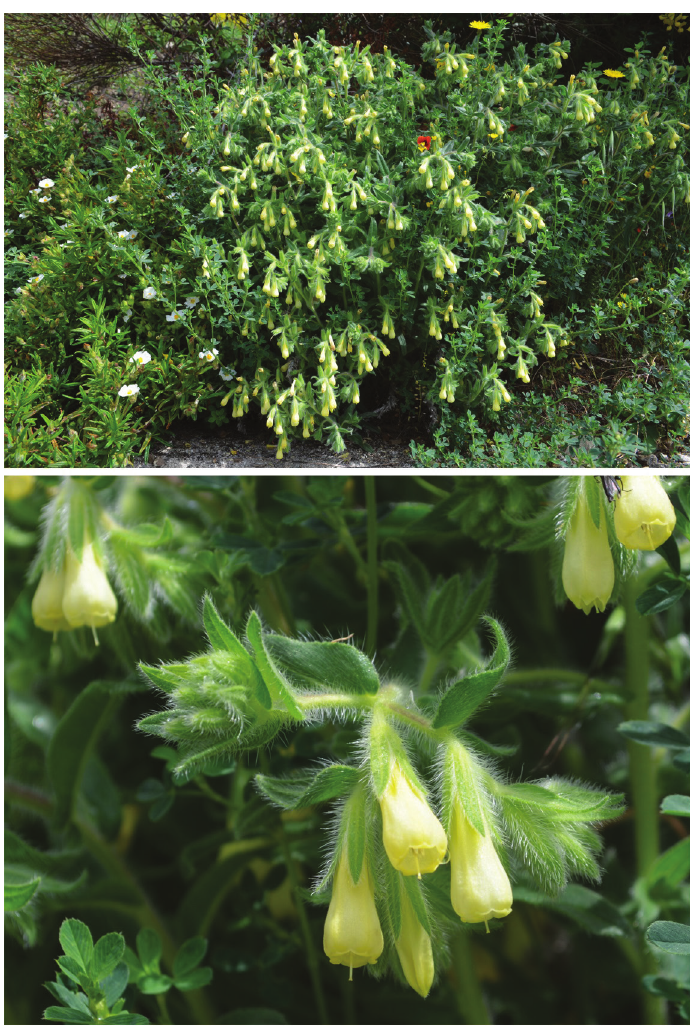
Figure 9. Onosma helvetica subsp. lucana near the village of Farneta (Castroregio, Cosenza, Calabria), a locality included in the Pollino National Park. Photograph by F.